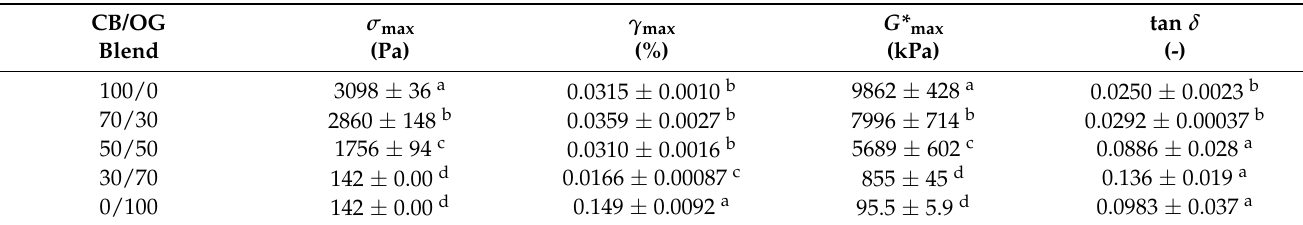
Table 2. Rheological parameters (limit values of LVE range) obtained at 20 ◦ C from amplitude sweeps for the different formulated CB/OG